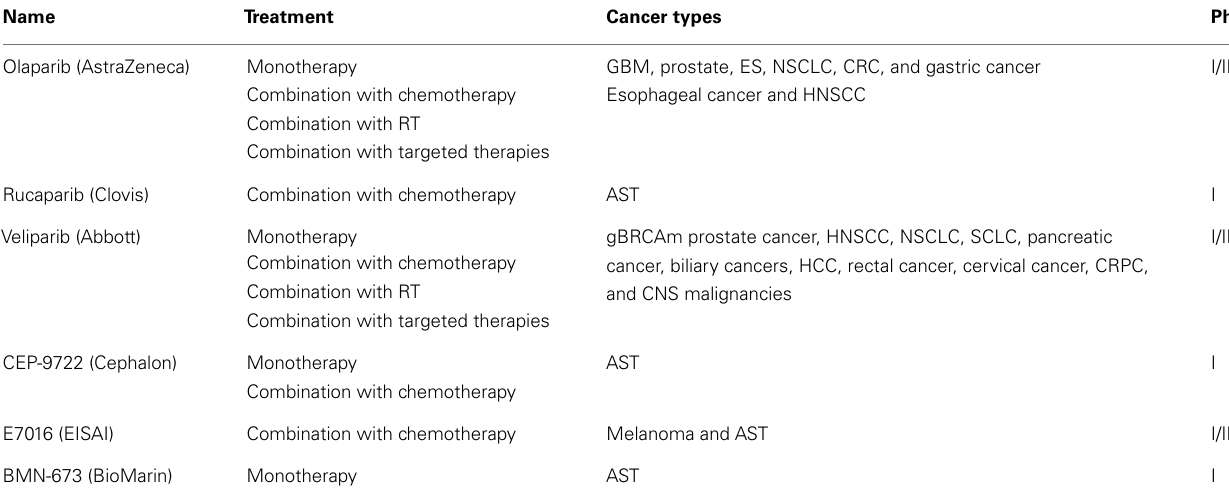
Table 1 | PARPi in clinical development (excluding breast and ovarian cancer) (19)